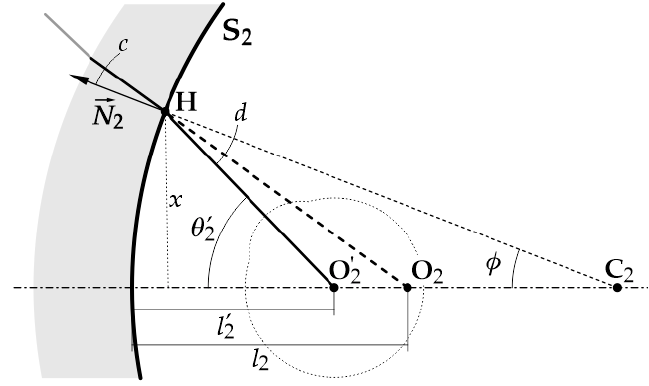
Figure 3. Parameters describing the refraction at the back surface of the